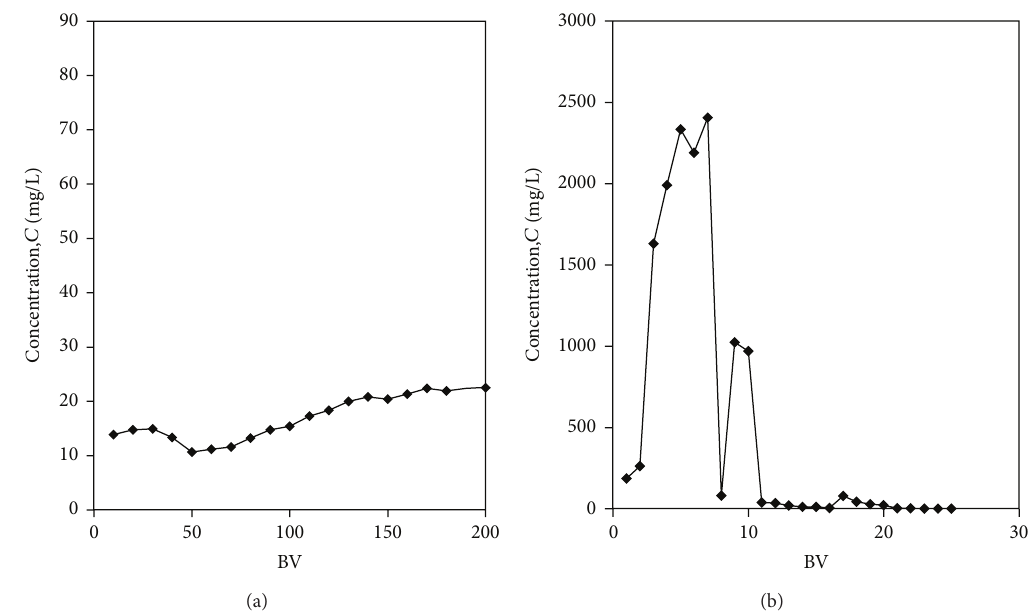
Figure 4: (a) The exhaustion breakthrough curve (first cycle). Initial chromium(III) concentration: 83mg/L; pH: 2.97 (installation I). (b) The regeneration curve (first cycle). Regenerant solution: 0.3 M H 2 O 2 ; 0.2M NaOH (installation I).